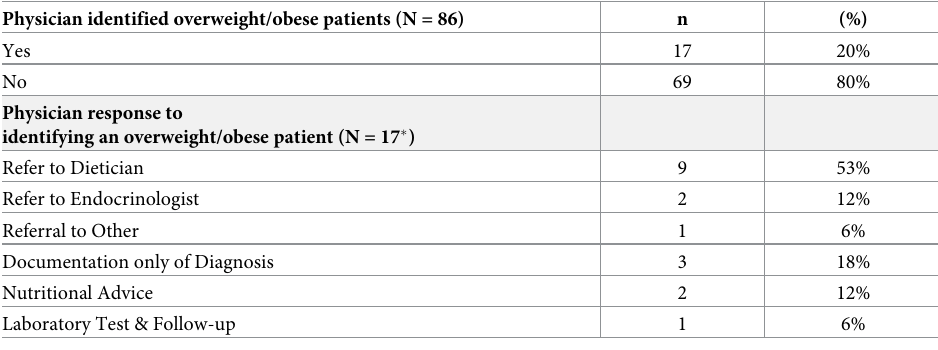
Table 2. Physician identification and management of overweight/obese status patients.